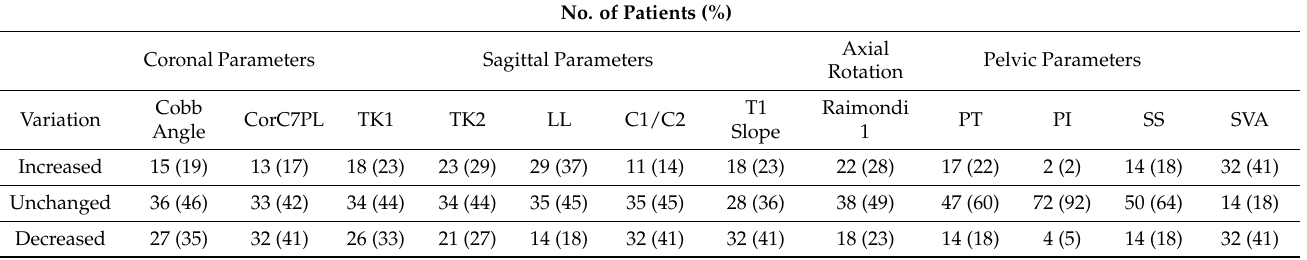
Table 2. Cobb angle for primary and secondary curves before and with C-brace. No. of Patients